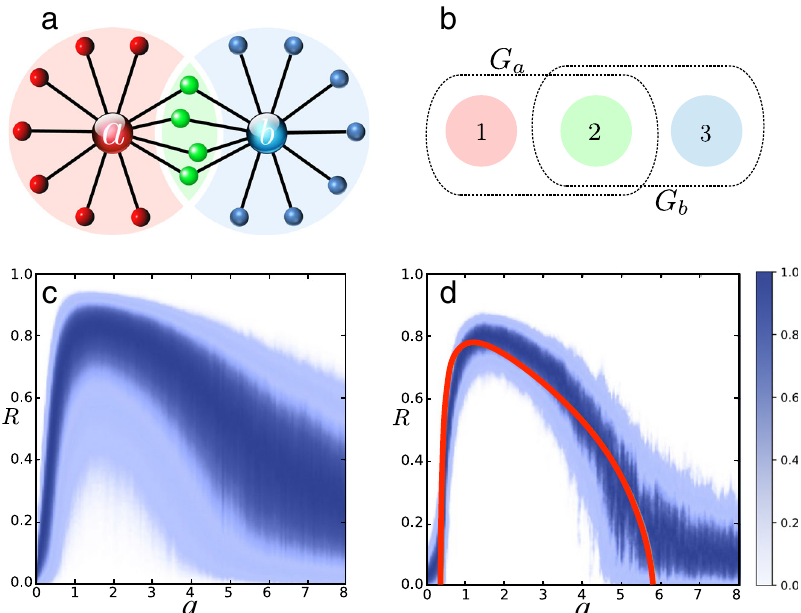
Fig. 1 Coherence resonance in an in fl uencer network. Distribution of the order parameter R versus the effective diffusion q in the in fl uencers. a In fl uencers a and b are hubs that couple strongly to the network, and all other nodes are regarded as followers. Three distinct partitions of followers are shown in red, blue, and green, which connect to in fl uencer a , b , and both a and b , respectively. In our simulation, each partition has 300 followers. b Mean- fi eld theory predicts that the interactions of the partition mean- fi elds take place in a hyper-graph mediated by the coupling functions G a and G b see Methods. c , d For each value of effective noise strength q in the in fl uencers, we plot the density of the global order parameter R on a color scale from 0 (white) to the maximum value (dark blue). At an optimal noise strength, the mean value of the global order parameter reaches a maximum, revealing the coherence resonance effect. In c the dynamical frequency gap between in fl uencers and followers ΔΩ / λ 0 = 18 is moderate, whereas in d ΔΩ / λ 0 = 198 is large. The solid red line in c is our analytical prediction. Table 1 Effective dynamical parameters in in fl uencer networks. We obtain these parameters as described in Methods. These are key parameters in the description of coherence resonance and the optimal noise strength in the in fl